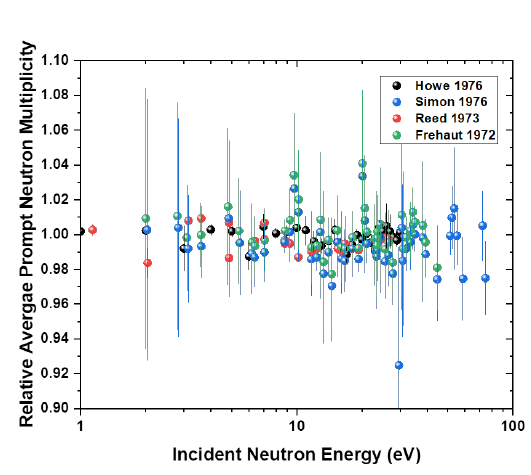
Figure 1. Relative average prompt neutron multiplicity from 1 eV to 100 eV for the 235 U(n,f) reaction. Data from Howe [12] are relative to the average ν P -value over incident neutron energies from 0.52 to 114 eV. Data from Simon [13] and Reed [14] were renormalized to the thermal ν P -value and data from Frehaut [15] were renormalized to ν P -value from 252